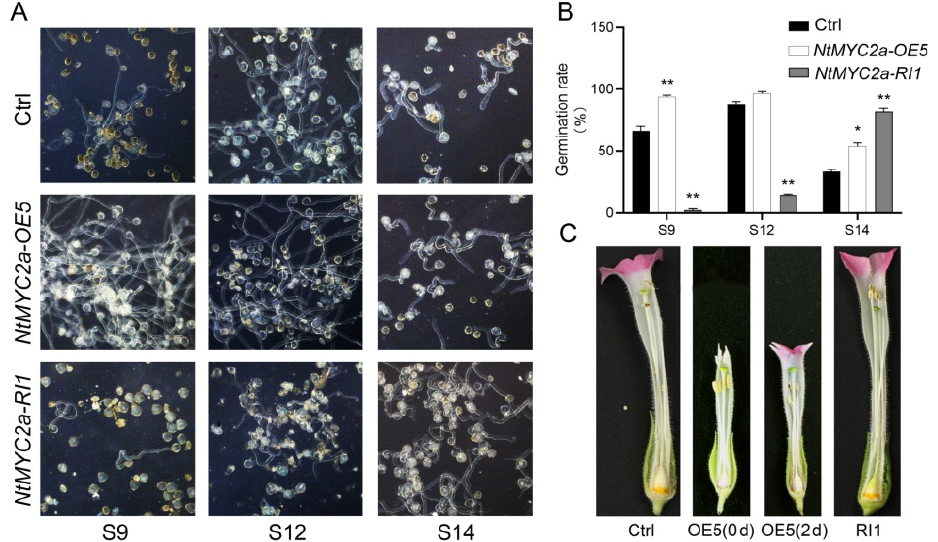
Figure 6. The pollen germination was delayed in the NtMYC2a knockdown plants. ( A ) Pollen germination of NtMYC2a -OE, NtMYC2a -RI and control plants at S9, S12 and S14; ( B ) Statistics of germination rate of NtMYC2a -OE, NtMYC2a -RI and control plants at indicated flower development stages. Results are shown as means ± SD, n = 100. Significant differences from the data of control plants are indicated: * p < 0.05, ** p < 0.01 (Student’s t -test); ( C ) The phenotypes of floral organs at S12. Ctrl, flower of control plants. OE5, flowers of NtMYC2a -OE plants at 0 days (0 d) and 2 days (2 d) after shedding. RI1, flower of NtMYC2a -RI plants.